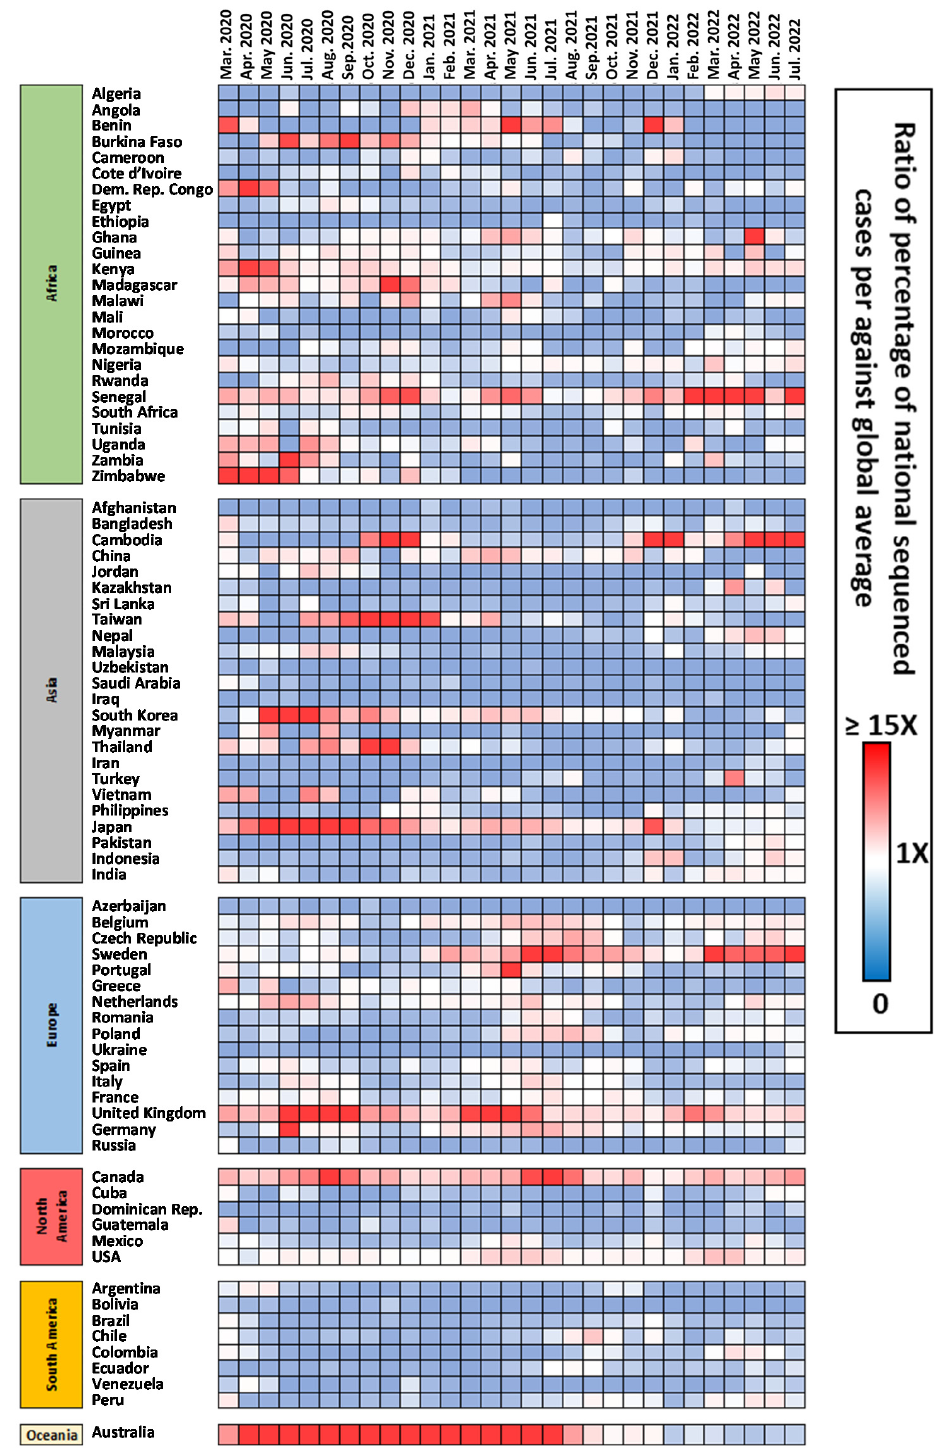
Figure 4. Heat map contextualizing the relative percentage of sequenced genomes in each country against the average percentages worldwide. Red points indicate that the percentage in that coun- try/month was higher than the average worldwide, white represents a similar average, while tones of blue indicate that the average of sequenced genomes was lower than the worldwide average.